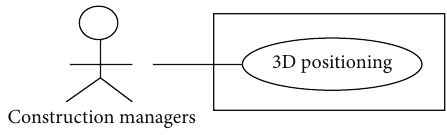
Figure 5: Use Case diagram.